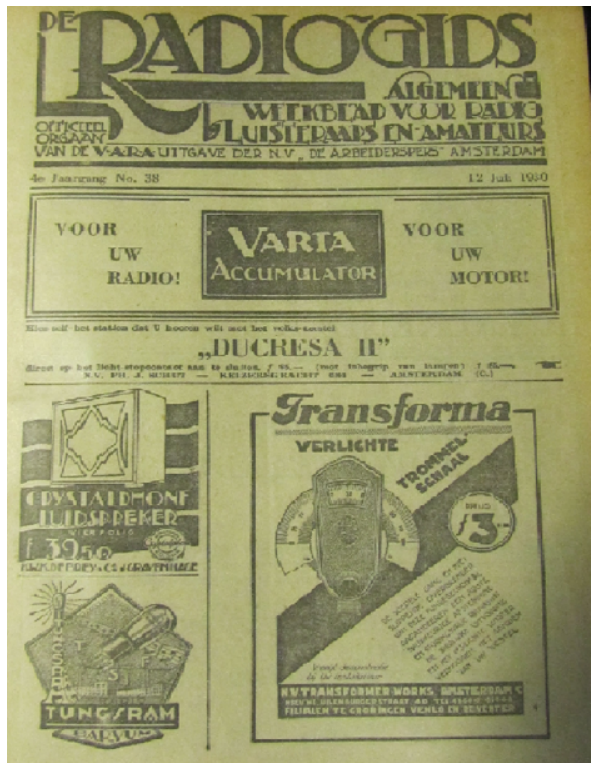
Fig. 1 Cover of De radiogids (12 July